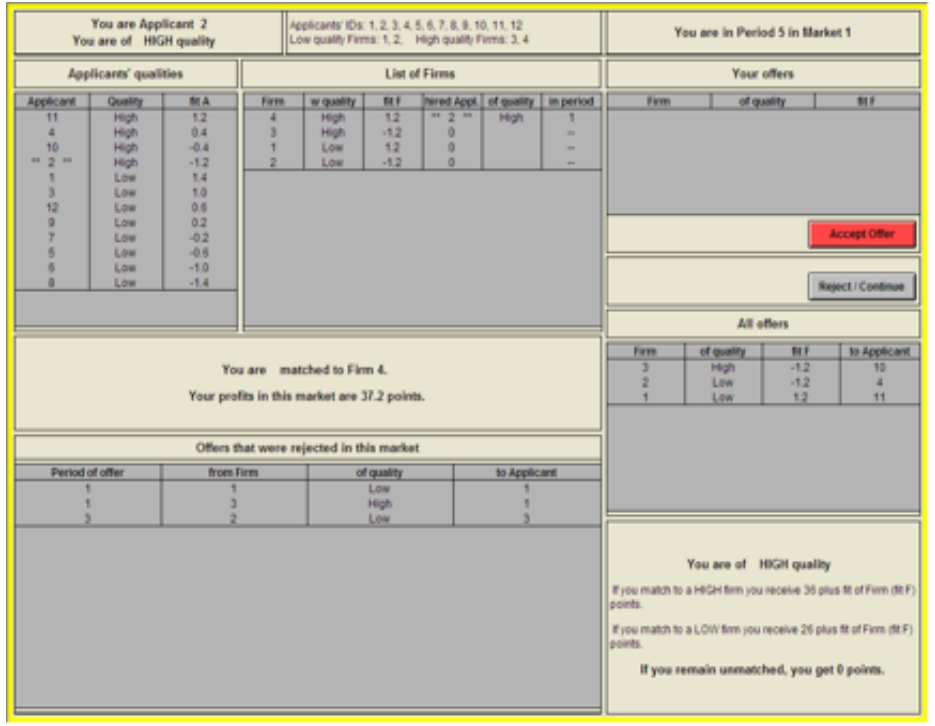
Figure 8. Applicant Screen, Periods